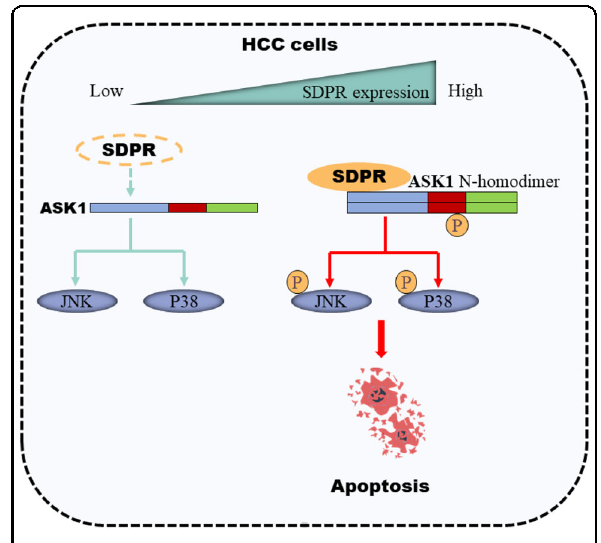
Fig. 8 A graphical model for SDPR-mediated apoptosis in HCC cells. SDPR interacted with ASK1 to facilitate ASK1 N-terminus- mediated dimerization and increased ASK1-mediated signaling to activate the JNK/p38 MAPKs and promote cell apoptosis in HCC with SDPR high